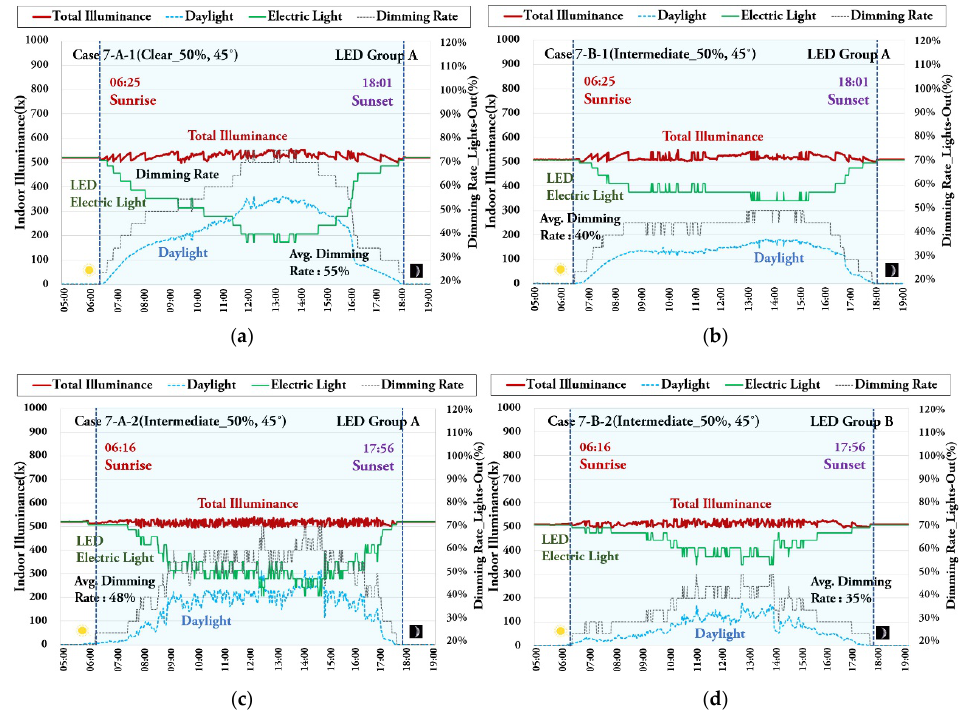
Figure 19. Illuminance and dimming rates under dimming controls integrated with manual blind controls. (Blind VP 50%, Slat angle 45°). (clear sky_9.25 and intermediate sky_09.17). ( a ) Case 7-A-1, ( b ) Case 7-B-1, ( c ) Case 7-A-2, and ( d ) Case 7-B-2 in Table 6.